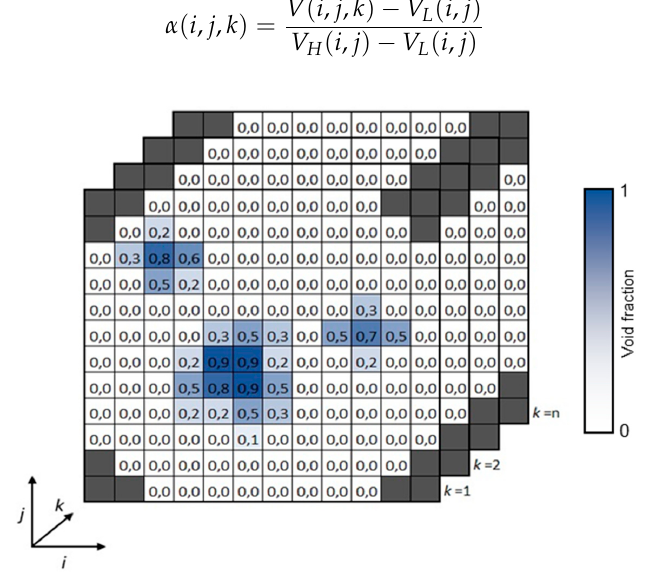
Figure 4. Spatial coordinates of the wire-mesh processing data. Void fraction is represented in the color scale.